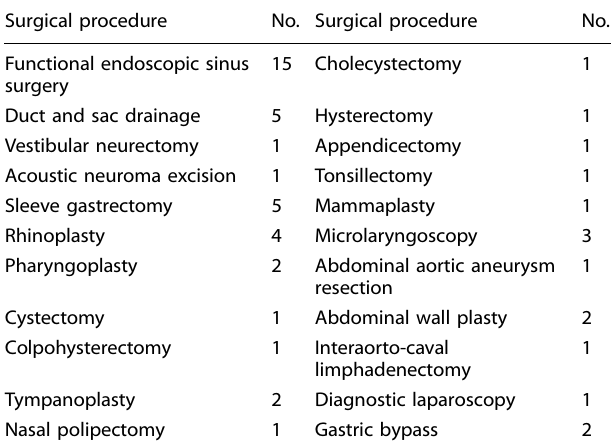
Abdominal aortic aneurysm